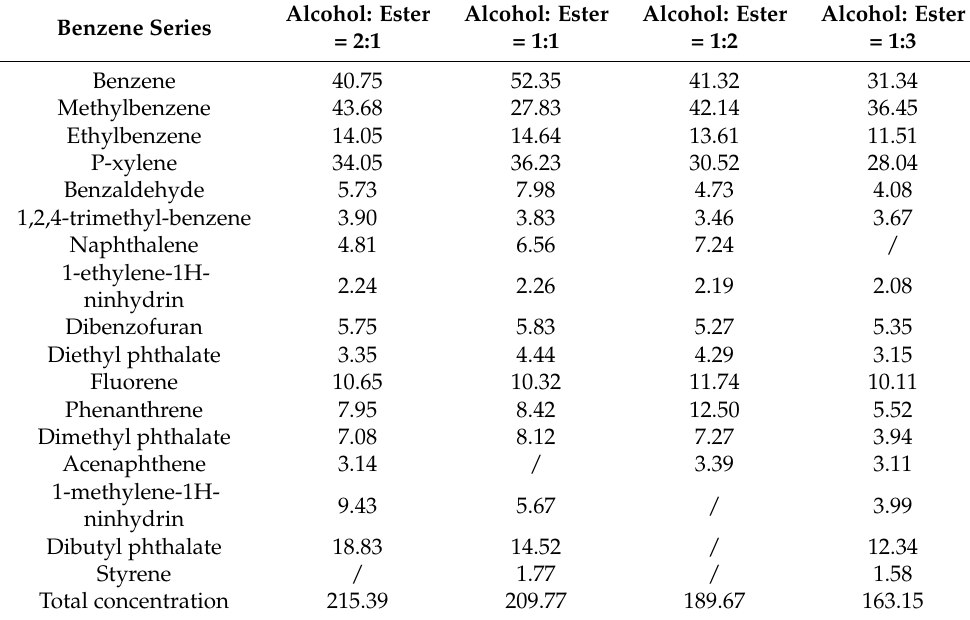
Table 3. The Benzene Series and total concentration released from MDF painted with mixed diluent prepared with different proportions of alcohol and ester ( µ g · m − 3